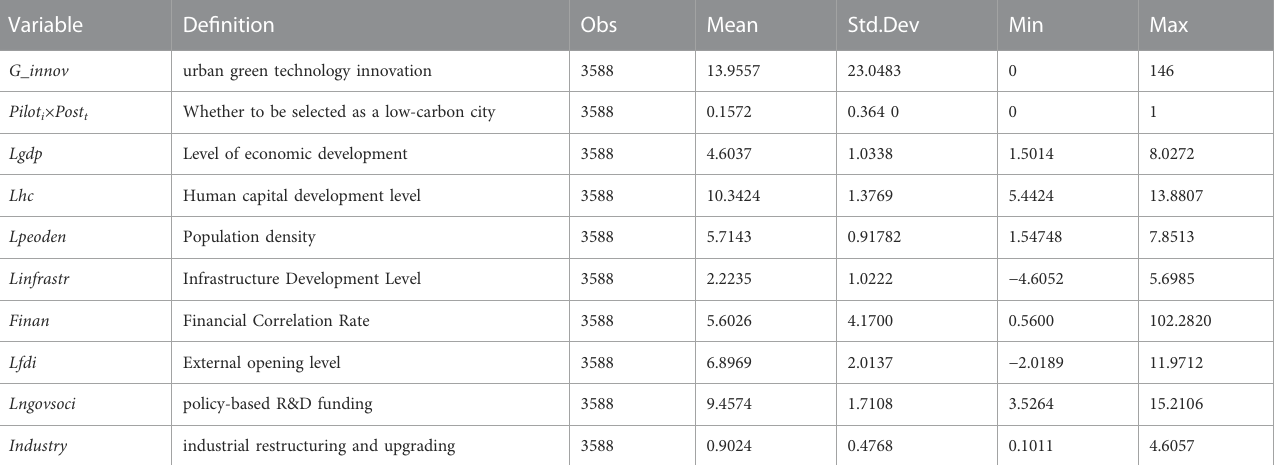
TABLE 1 Descriptive statistics of main